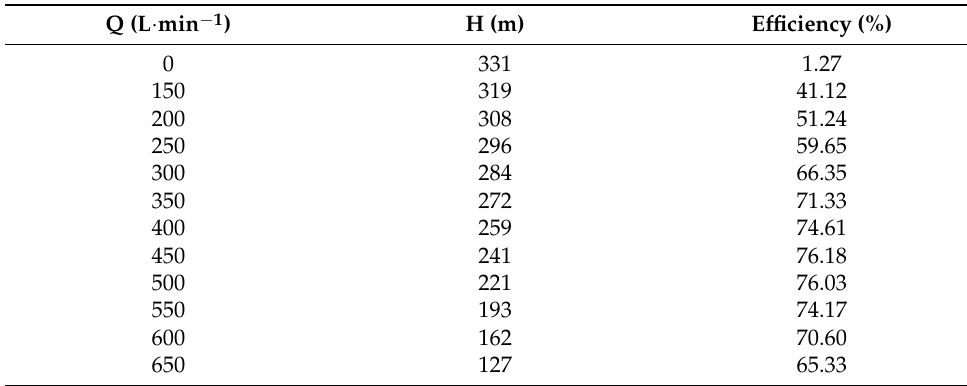
Table 2. Characteristic and efficiency curves of the installed